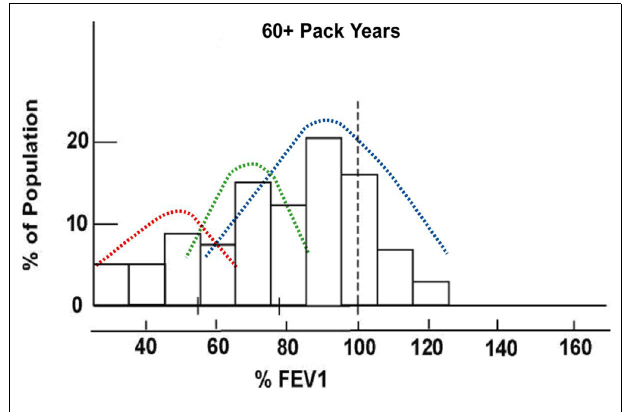
FIGURE 1 |Trimodal distribution of %predicted FEV 1 in current and former smokers with heavy smoke exposure defining “susceptible” and “resistant” smokers (modified from Burrows etal.,